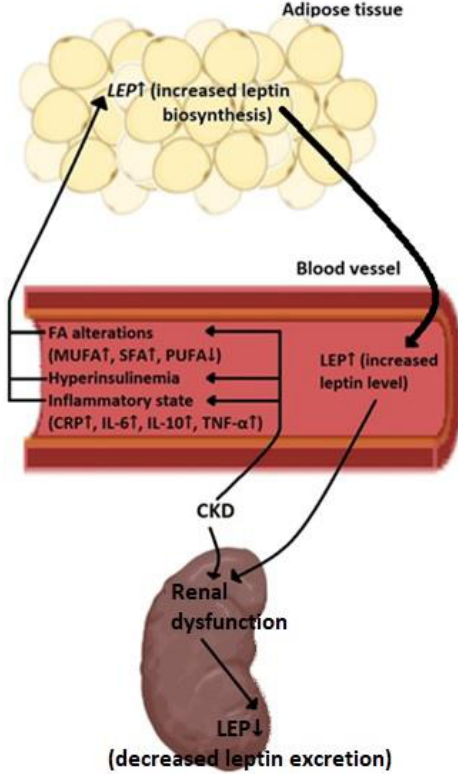
Figure 1. The potential mechanisms leading to hyperleptinemia in patients with CKD. SFA—saturated fatty acids, MUFA—monounsaturated fatty acids, PUFA—polyunsaturated fatty acids, CRP—C Reactive Protein, IL—interleukin, TNF-α—tumor necrosis factor α. The bold arrow symbolizes the increased secretion of leptin.